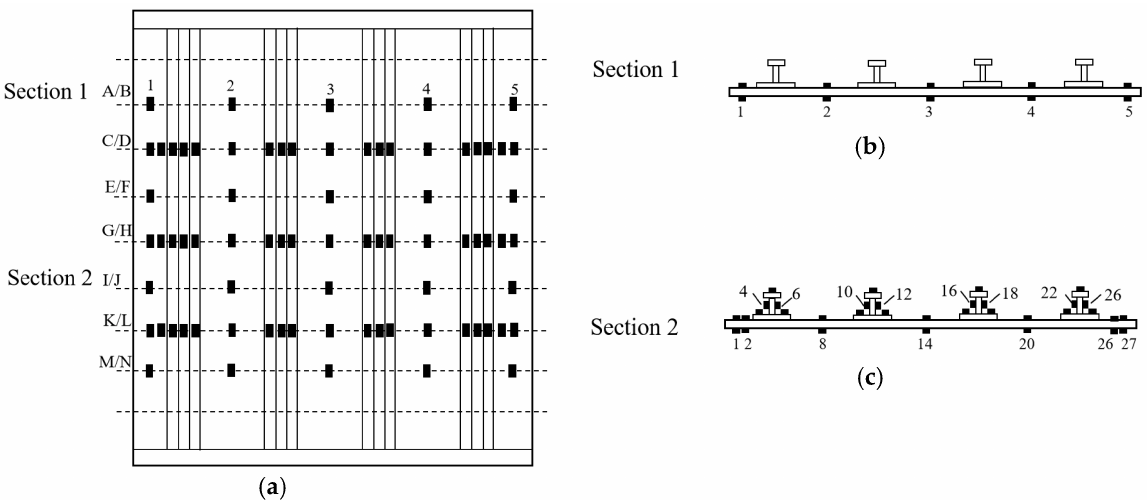
Figure 3. CAI test fixture and installation diagram. ( a ) Schematic diagram of compression test fixture; ( b ) Photo of compression test.